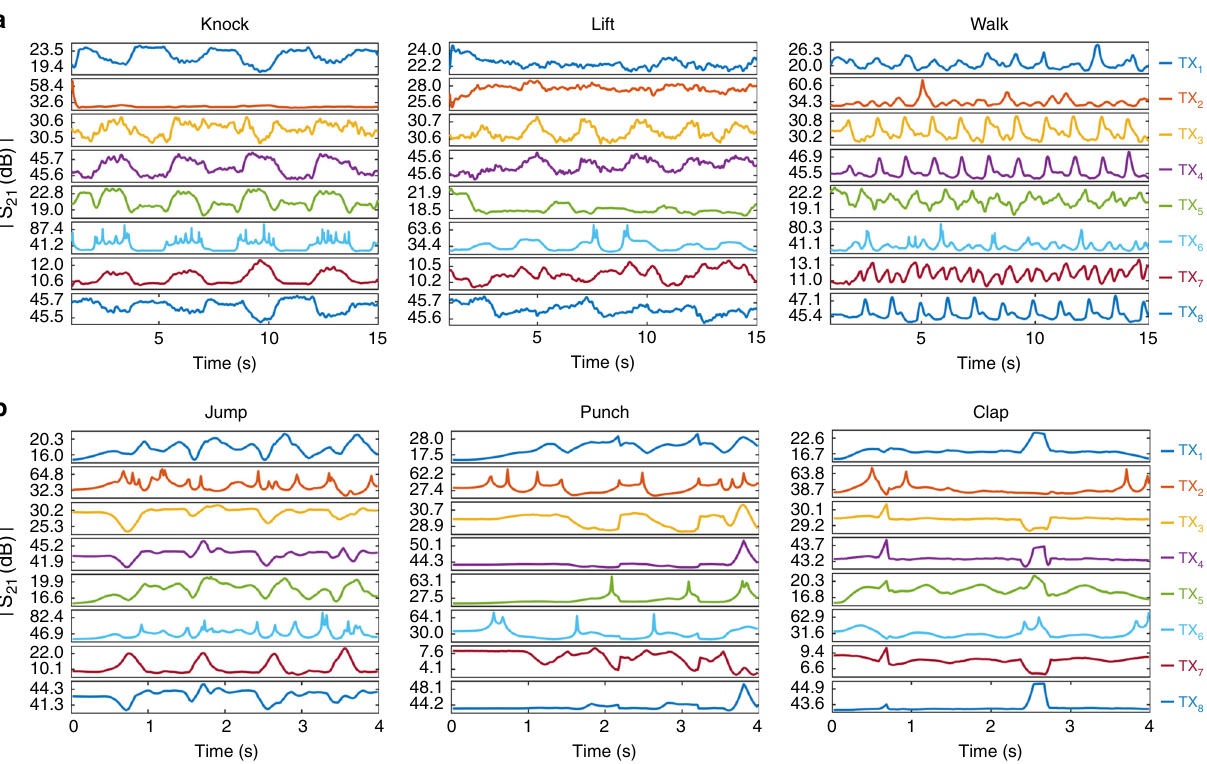
Fig. 2 Synthetic magnetic induction (MI) motion data. The forward voltage gain S 21 between the receiver (RX) and transmitters (TX 1 – TX 8 ) are generated using the proposed MI model and the human motion data captured for different activities in two datasets: a Biological Motion Library (BML) and b Berkeley Multimodal Human Action Database (MHAD).